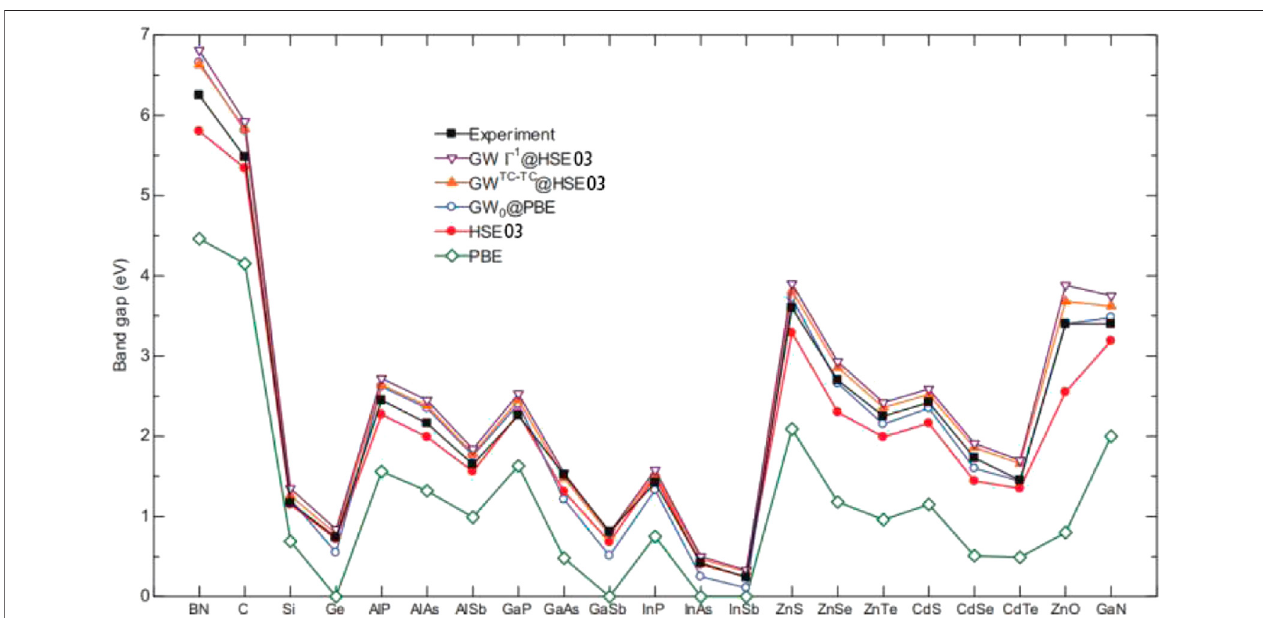
FIGURE 14 | Bandgaps obtained by various DFT approximations (PBE, HSE03, GW 0 @PBE, GW TC-TC @HSE03, and GW Γ 1 @HSE03) and the corresponding experimental values. PBE semilocal functional has thelargest deviation. Thethree fi ttingresults related toGW method are consistent with experimental bandgapvalues.